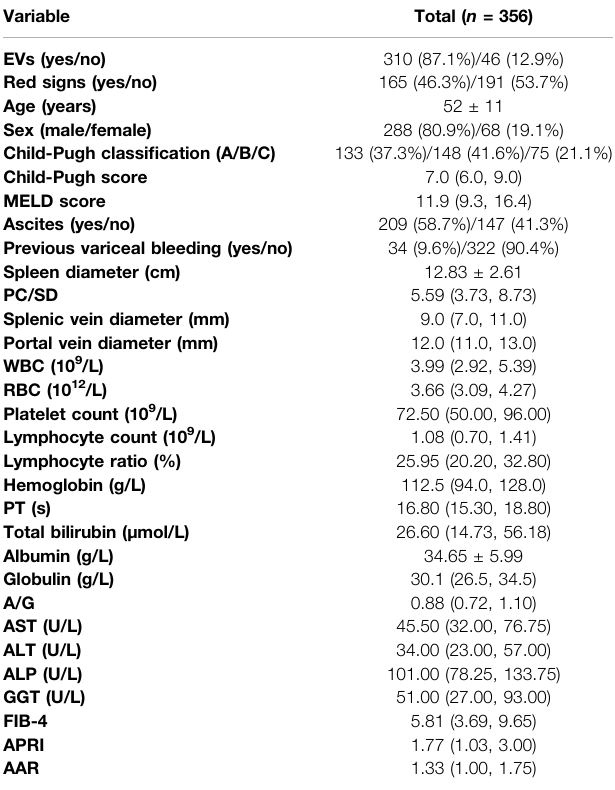
results or prediction model results. All statistical analysis were TABLE 1 | Demographic and clinical characteristics of 356 patients.